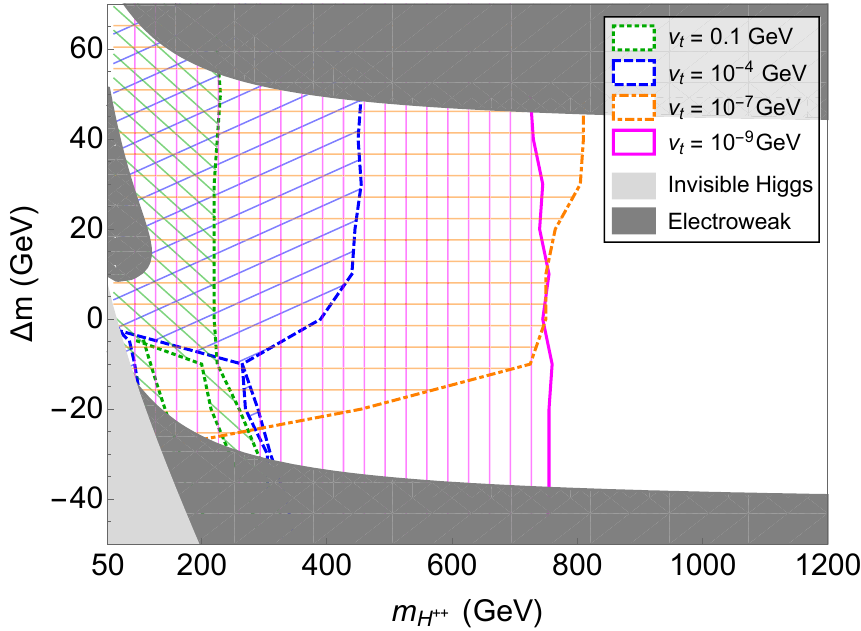
Figure 5 . The summary of the bounds from collider, invisible Higgs decay and the electroweak precision test. The excluded regions from collider searches are represented by hashed green, blue, orange and magenta regions for v invisible Higgs and electroweak bounds are independent of v grey shaded regions respectively.